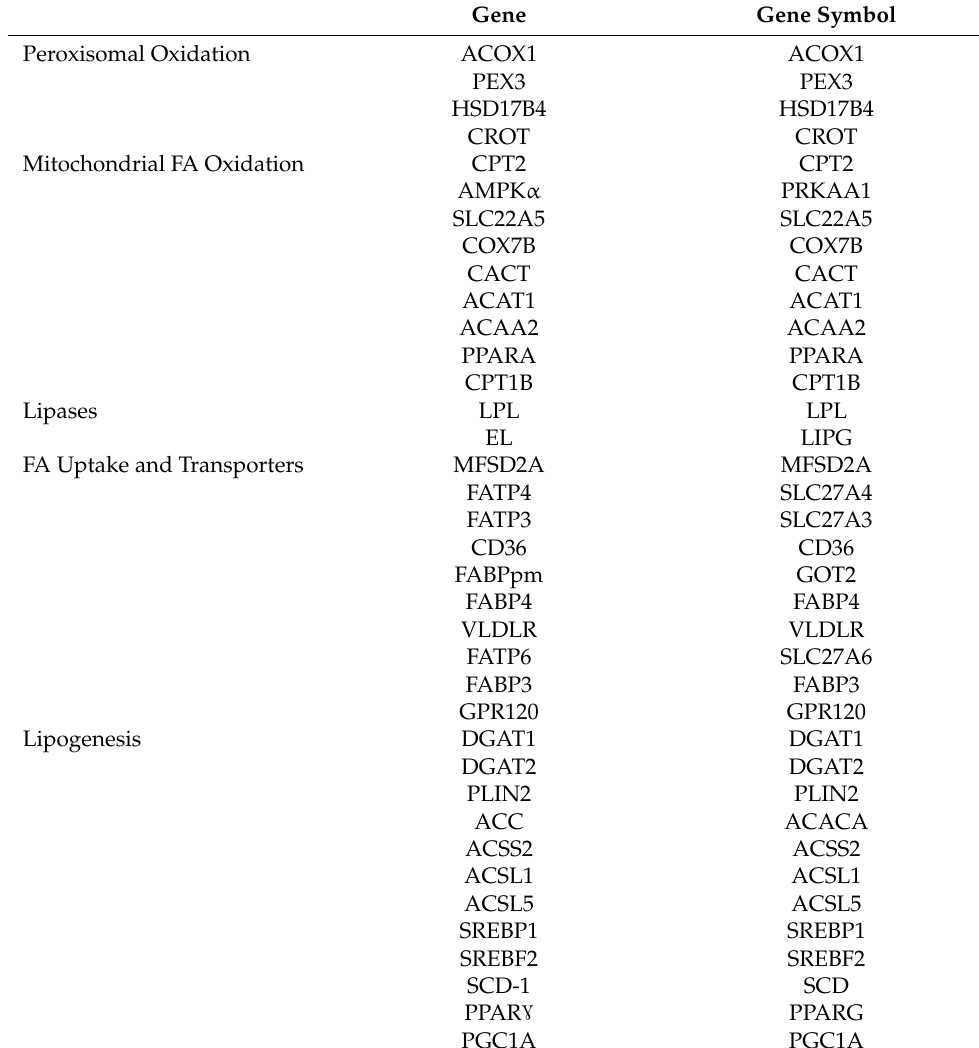
Table A2. Lipid Metabolism Genes.